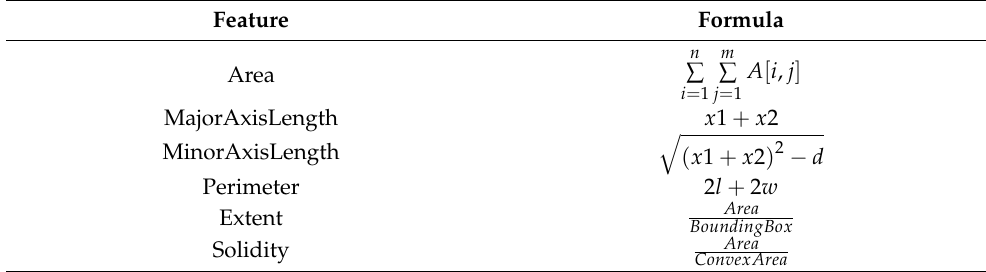
Table 2. Overview of geometric